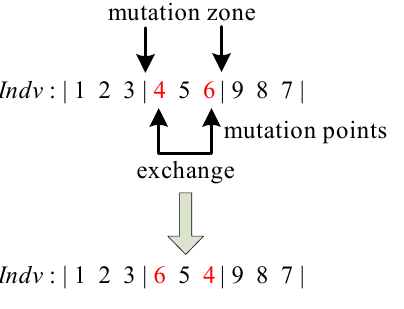
Figure 4. An example of the mutation